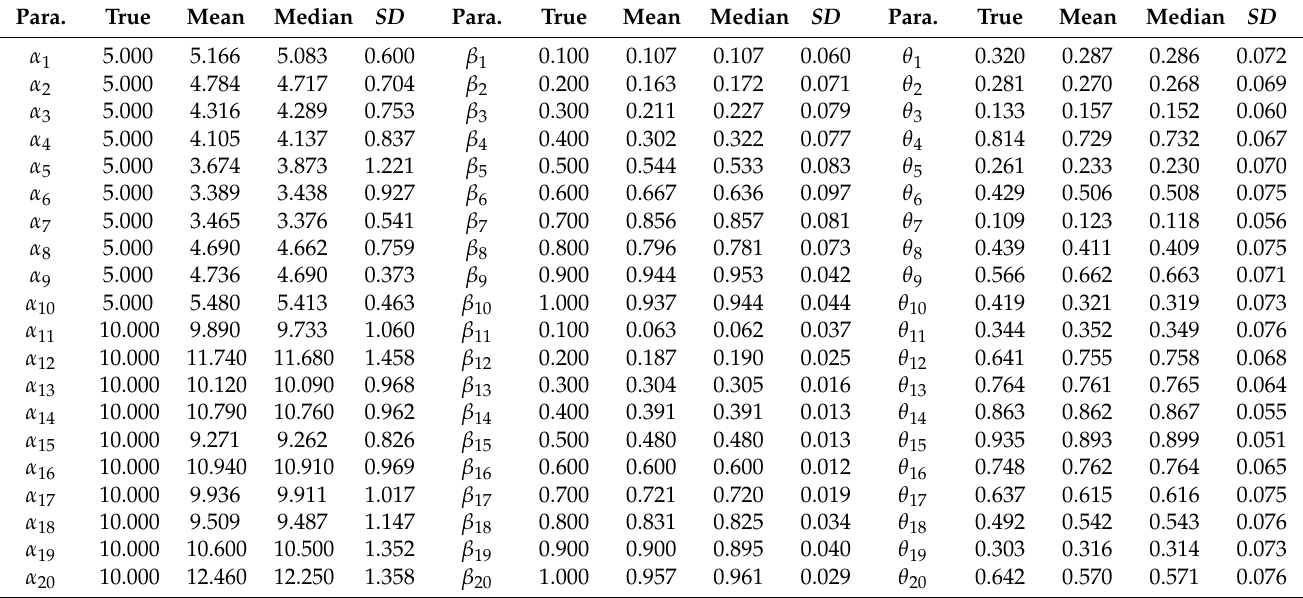
Table 2. Simulation Data Marginal Density Summary